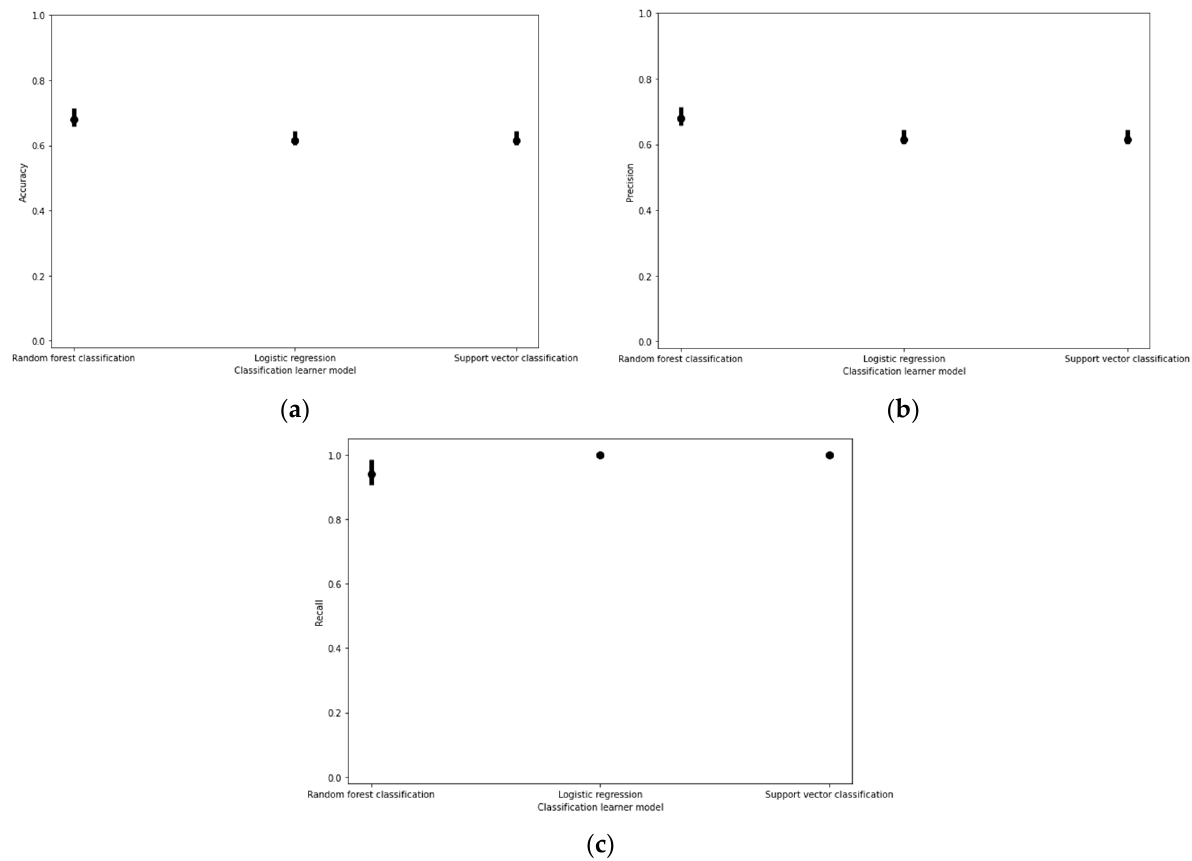
Figure 2. ( a ) Cell viability classification model performance based on accuracy, ( b ) precision, and ( c ) recall scores under fivefold cross validation. The upper and lower bounds of the error plots represent the maximum and minimum scores produced amongst all five combinations of one fold being trained and tested on the remaining four